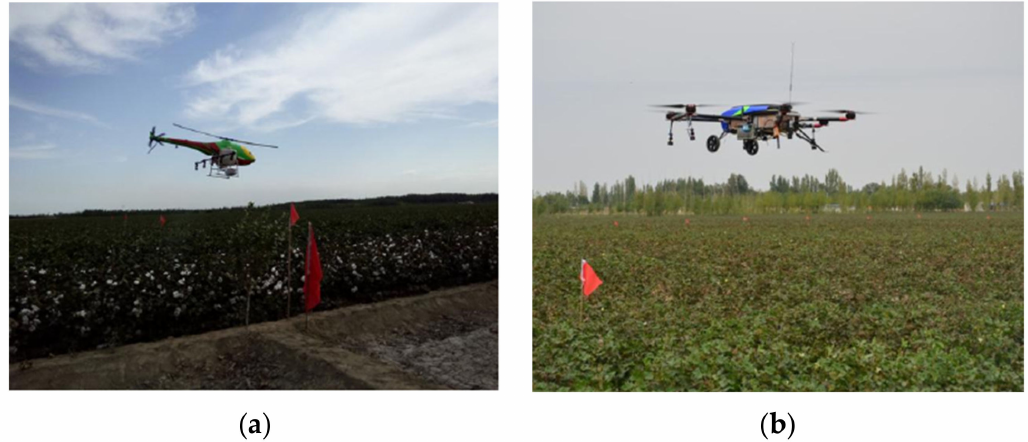
Figure 5. HY-B-15L single-rotor plant protection unmanned helicopter for cotton defoliant spray ( a ) and TXA616 plant protection UAV for rice growth regulator spray ( b )